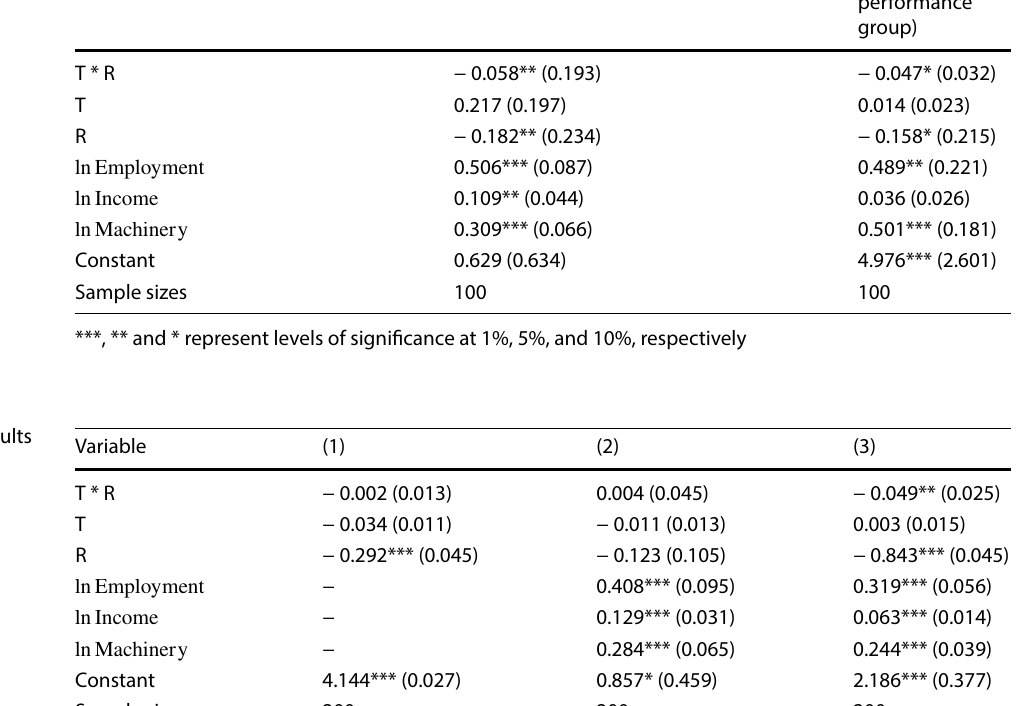
Case Study Table 12 Policy treatment effect on different groups of cities